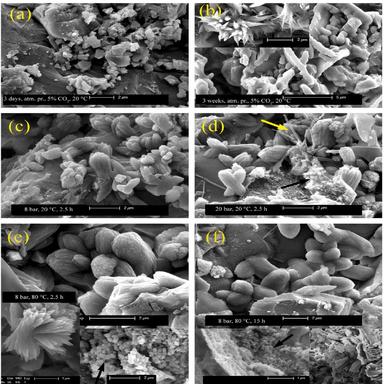
Morphology of the outer edge of the SS specimens prepared in (a) a carbonation chamber for 3 d; (b) a carbonation chamber for 3 weeks; (c) a reactor at 8 bar CO2 and 20 ◦C for 2.5 h; (d) a reactor at 20 bar CO2 and 20 ◦C for 2.5 h; (e) a reactor at 8 bar CO2 and 80 ◦C for 2.5 h; and (f) a reactor at 8 bar CO2 and 80 ◦C for 15 h .